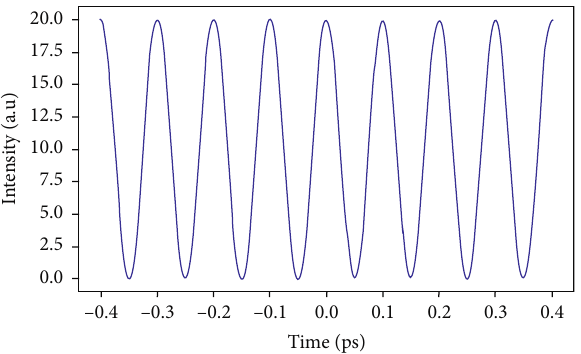
Figure 3: Intensity of the Michelson interferometer.